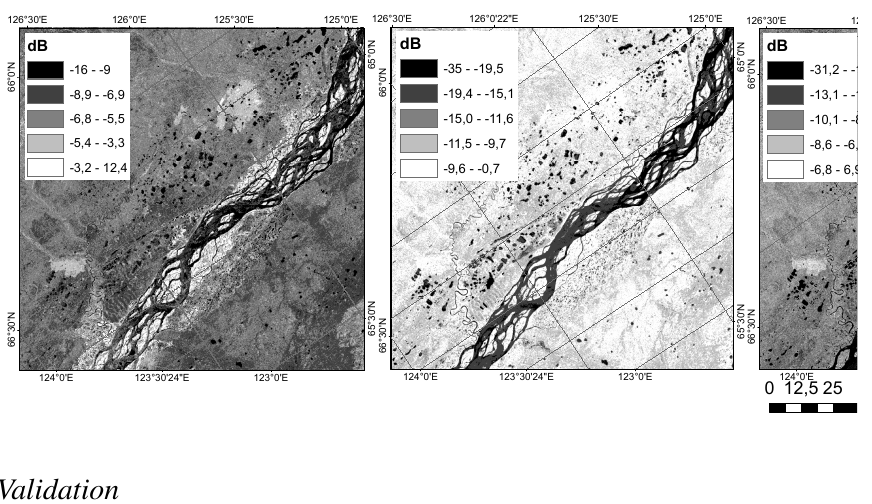
Figure 6. The 95th percentile ( left ) and the 5th percentile ( middle ) of the backscatter time series, which are used in the classification tree in comparison to a single day backscatter ( right ), mapped in Universal Polar Stereographic projection. Extent: S1 in Figure 3.